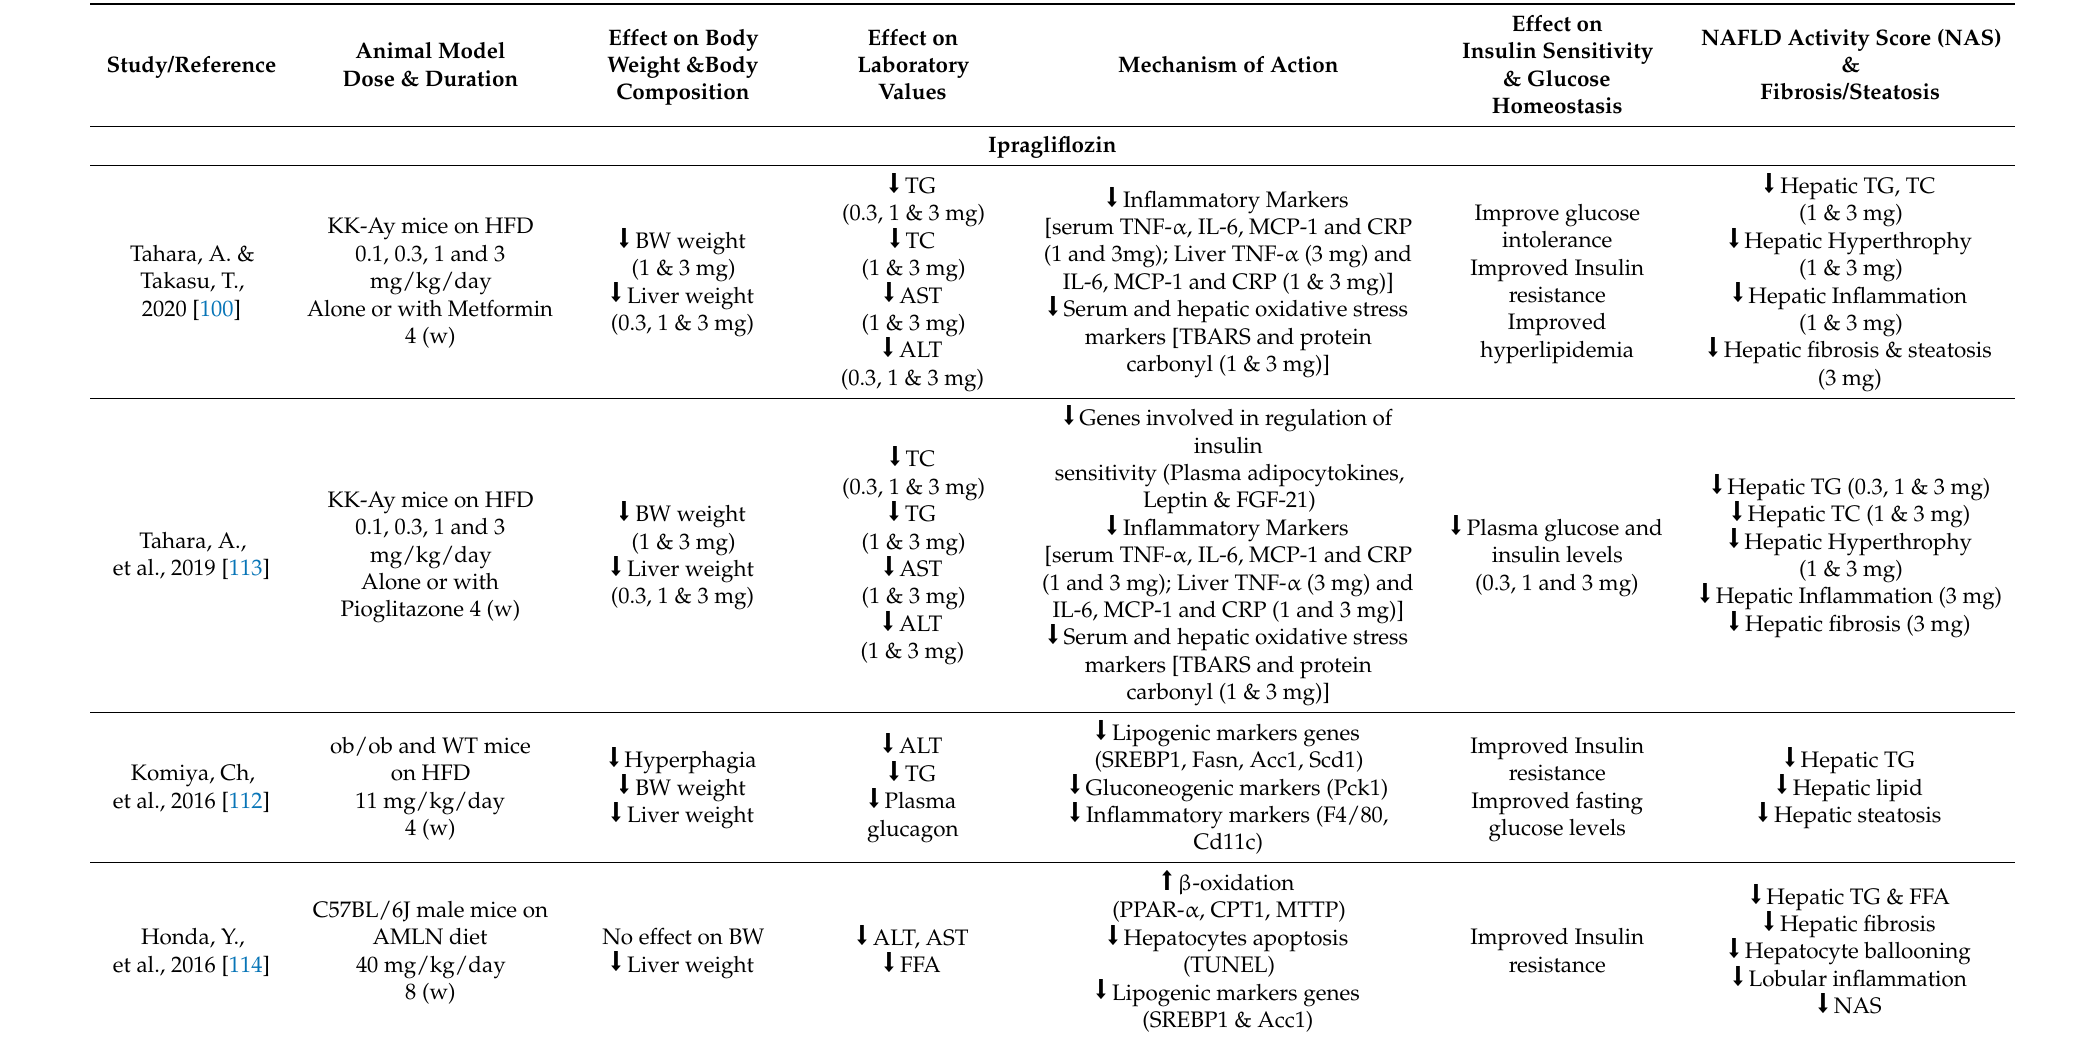
Table 1. Key animal studies regarding the impact of empagliflozin on NAFLD/NASH.